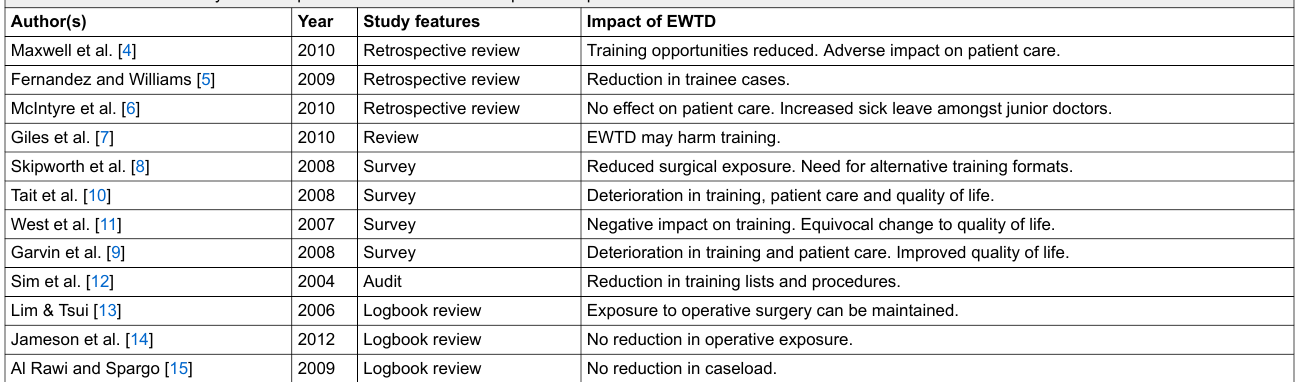
Table 1: Literature summary on the impact of the EWTD within the practical specialities. Author(s)